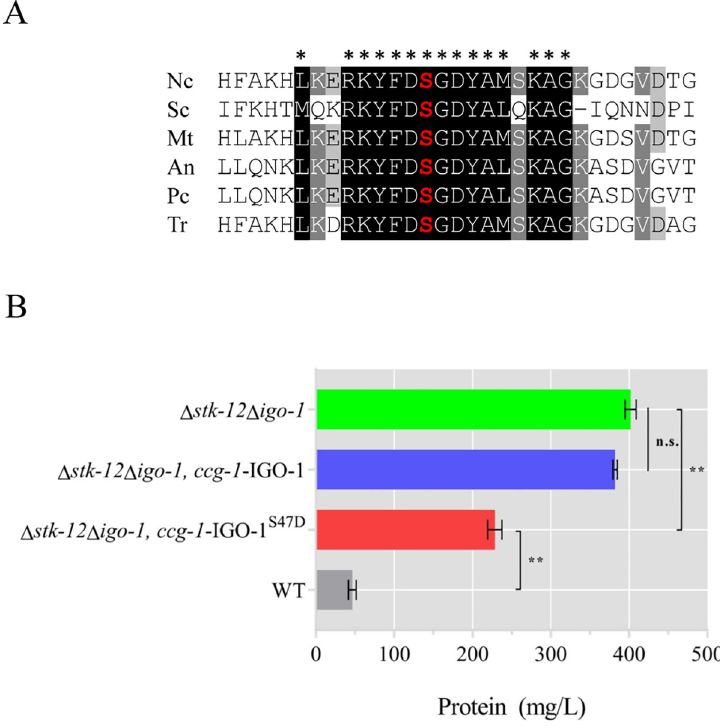
Fig 7. IGO-1 is activated by STK-12 via phosphorylation. (A) Amino acid sequence alignment of conserved domain from IGO-1 homologs in Neurospora (NCU03860), Saccharomyces (NP_014242.1), Myceliophthora (XP_003664474.1), Aspergillus (XP_001392163.1), Penicillium (EPS31852.1) and Trichoderma (XP_006963064.1). Asterisks indicate conserved amino acids; phosphorylation site is shown in red. (B) Mutational analysis of S47 of IGO-1. N . crassa WT strain, Δ stk-12 Δ igo- 1,and mutants expressing either a wild-type copy of igo-1 or mutated igo-1 allele were separately inoculated into Avicel medium and batch-cultured for 3 days. Total extracellular protein concentration in culture broth was measured. Values represent means of at least three biological replicates, error bars show standard deviation. Statistical significance was determined by two-tailed Student’s t -test ( �� , P < 0.01; n. s., not significant).